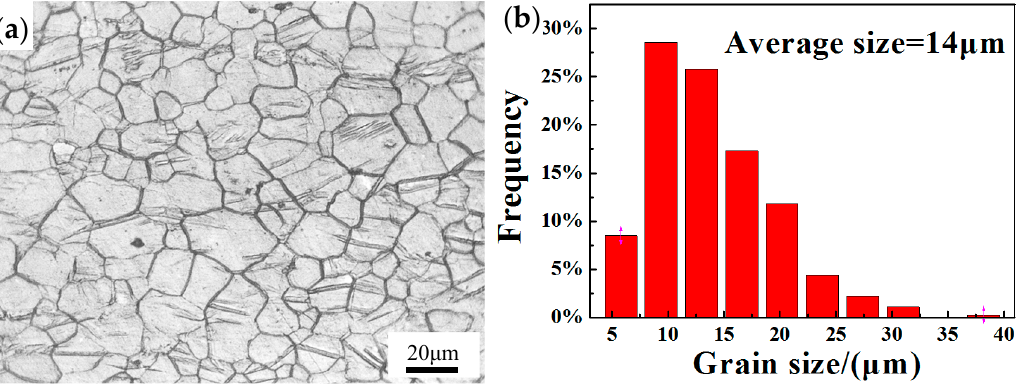
Figure 2. Grain size diagram of AZ31B after heat treatment at 400 °C for 15 min. Figure 2. Metallographic microstructure ( a ) and grain size diagram ( b ) of AZ31B after heat treatment at 400 ◦ C for 15